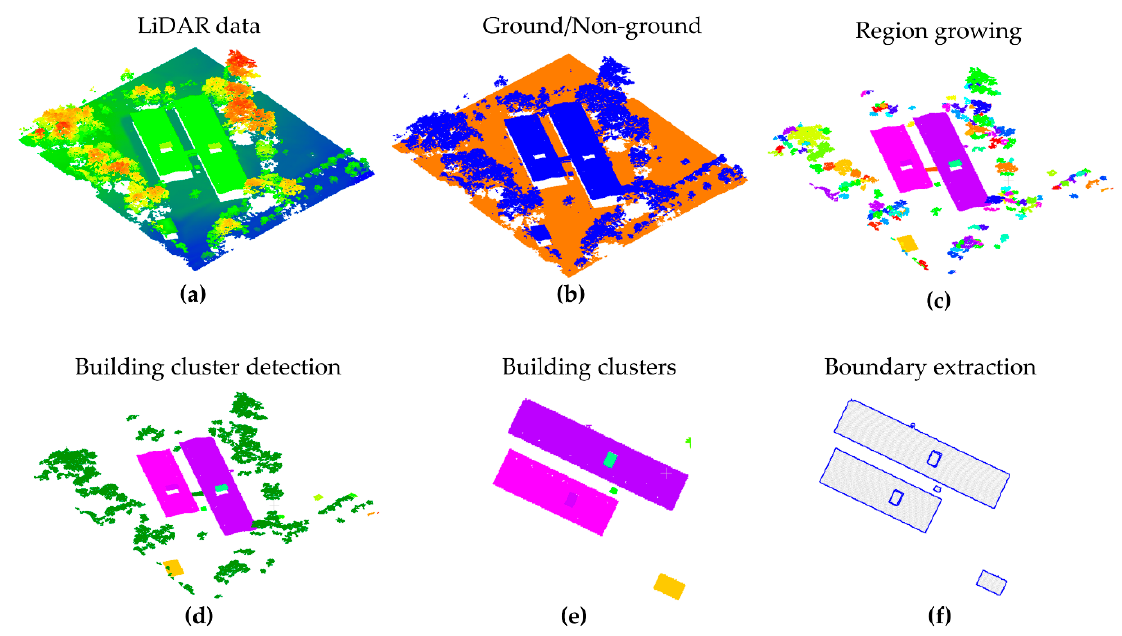
Figure 3. Building detection and building boundary extraction. Original point cloud ( a ). Result derived from the separation between ground (orange) and non-ground (blue) ( b ). Clusters obtained from region growing ( c ). Separation between building and vegetation (green) ( d ). Building clusters ( e ). Building boundaries extracted using the adaptative alpha-shape algorithm ( f ).